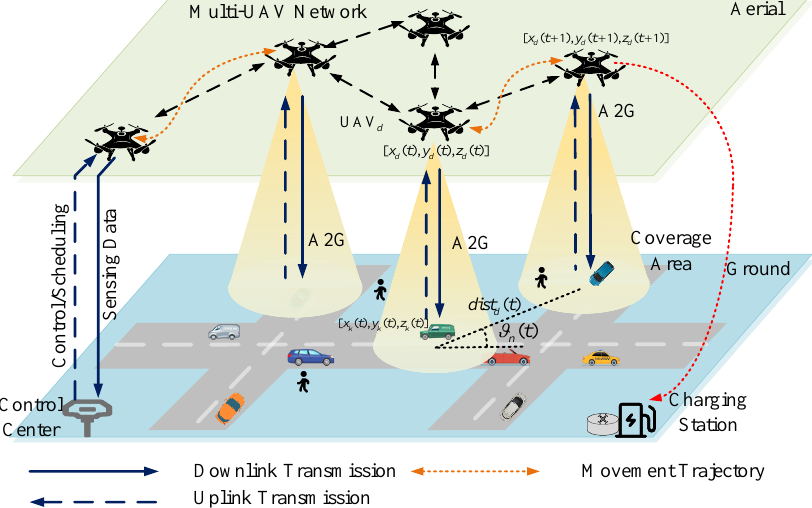
Figure 1. Multi-UAV-assisted communication